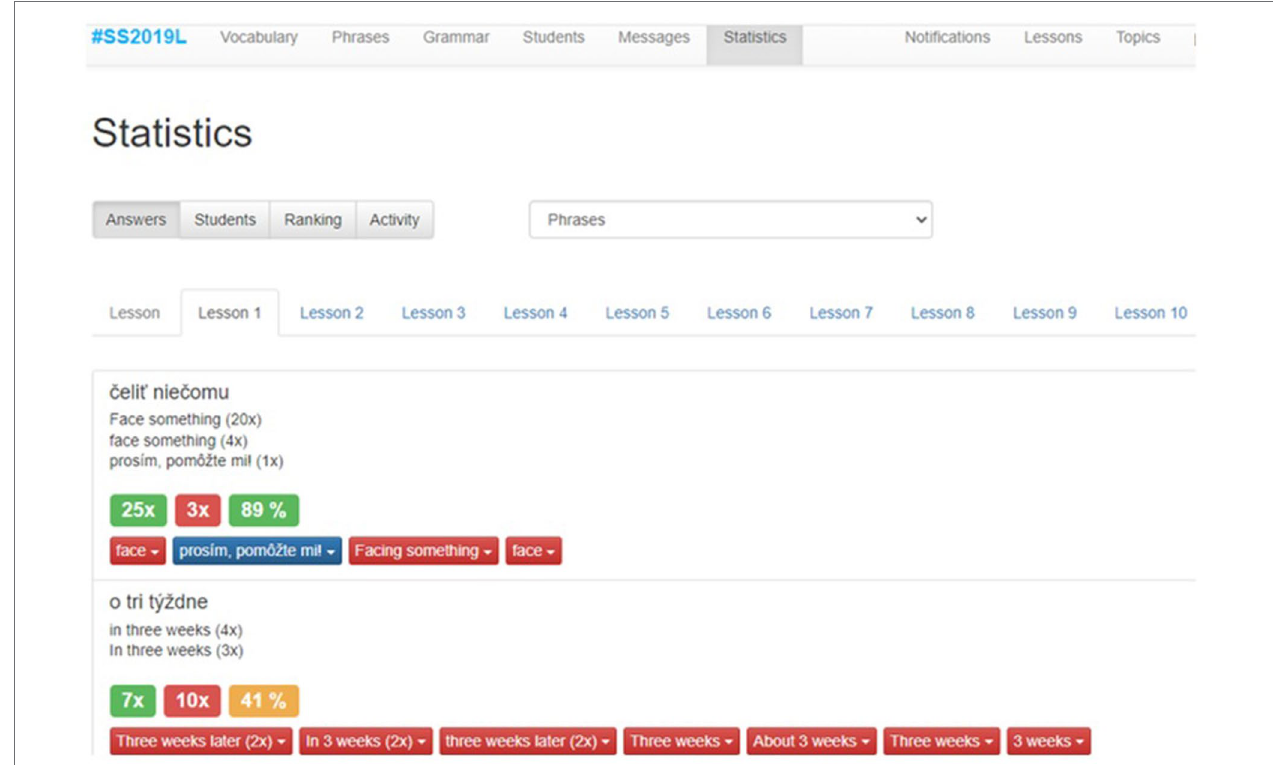
FIGURE 1 | The web part of the application designed for the